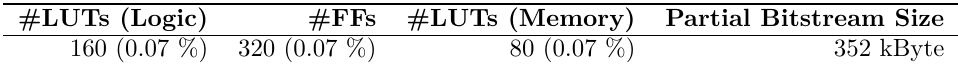
Table 2: Hardware design resource utilization for the pBlock ( Hardware Nanomites dynamic design part) synthesized for a xcku040-2ffva1156e